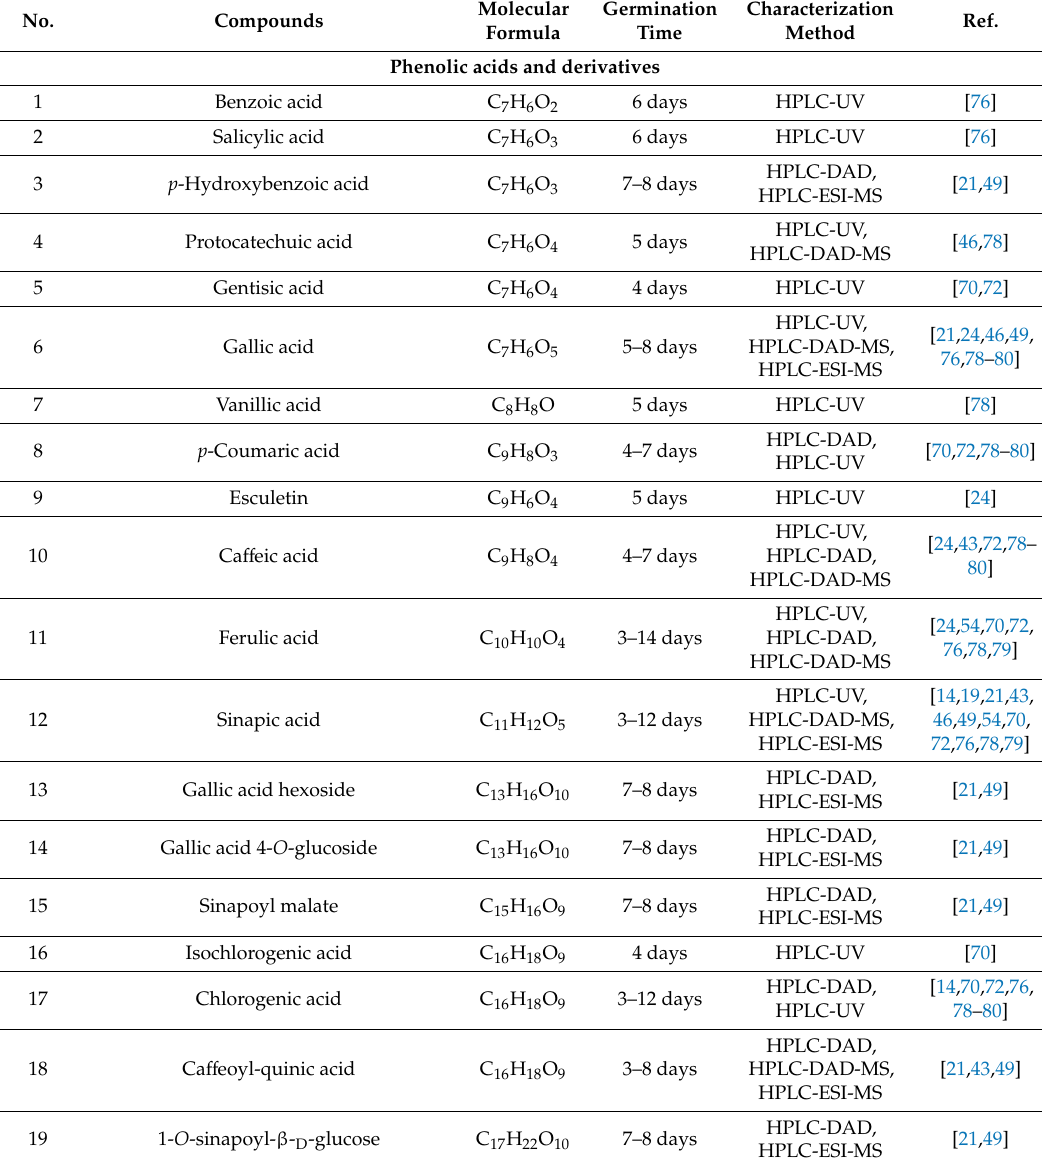
Table 3. Analysis of phenolic compounds in broccoli sprouts and